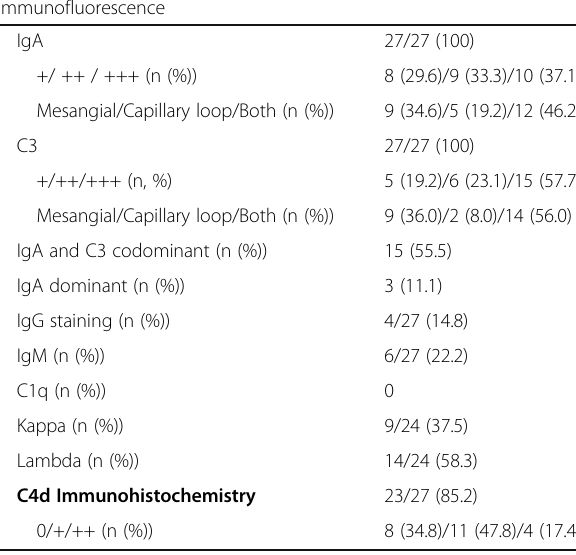
Table 4 Immunofluorescence and immunohistochemistry